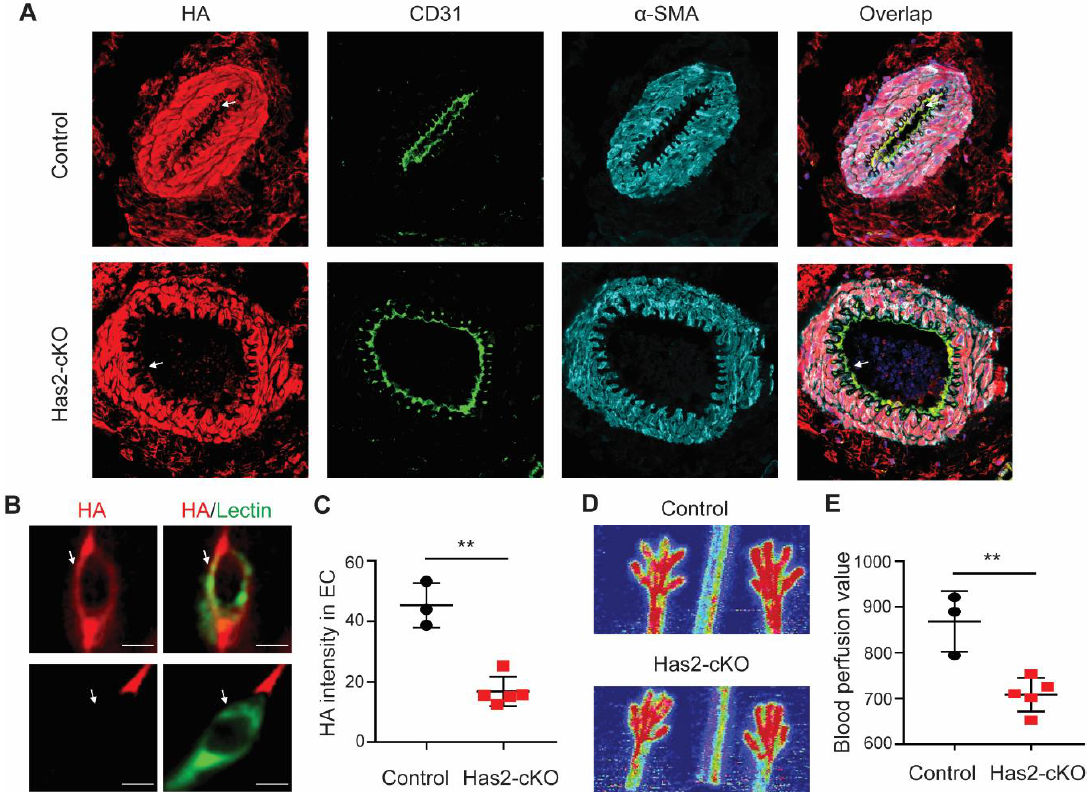
Figure 1. Loss of hyaluronan in endothelial cells (ECs) results in impaired perfusion in hindlimb. ( A ) Representative images of arteries and ( B ) small capillaries in gastrocnemius muscle of endothelial specific conditional hyaluronan synthase 2 KO (Has2-cKO) mice ( n = 5) and control mice ( n = 3), stained for the luminal glycocalyx with the hyaluronan (HA) binding probe Ncan-dsRed (red), α-CD31 and lectin from Bandeiraea simplicifolia (Green, BS1-lectin) for endothelial localization, α-SMA for smooth muscle cells. ( C ) Quantification of HA intensity colocalized with lectin in ECs. ( D ) Representative images and ( E ) quantification of paw perfusion by laser Doppler perfusion imaging (LDPI) before ligation shows a significantly lower perfusion in the hindlimb of HAS2-cKO. Values are given as mean ± SD. * p < 0.05, ** p < 0.01.